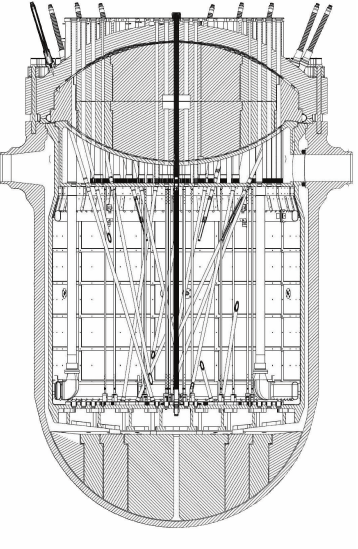
Figure 2: Reactor pressure vessel cutaway view. Coolant enters from the left, goes down to the lower plenum, flows through the 451 coolant channels (not represented) up to the upper plenum, and leaves the vessel through the hot leg at the right of the